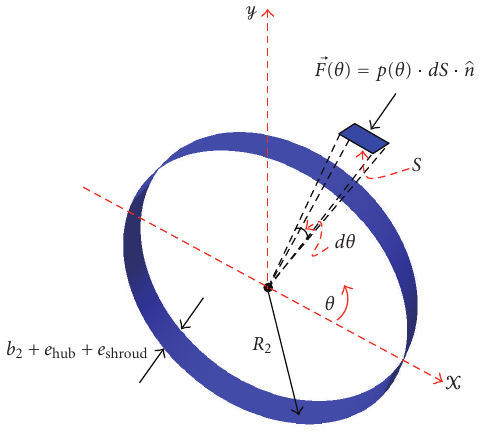
Figure 13: Radial force integration around the impeller periphery.